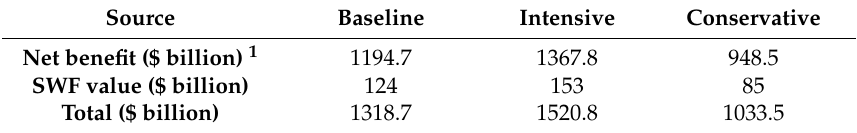
Table 6. Welfare gained from NG by three generations, according to the three scenarios.